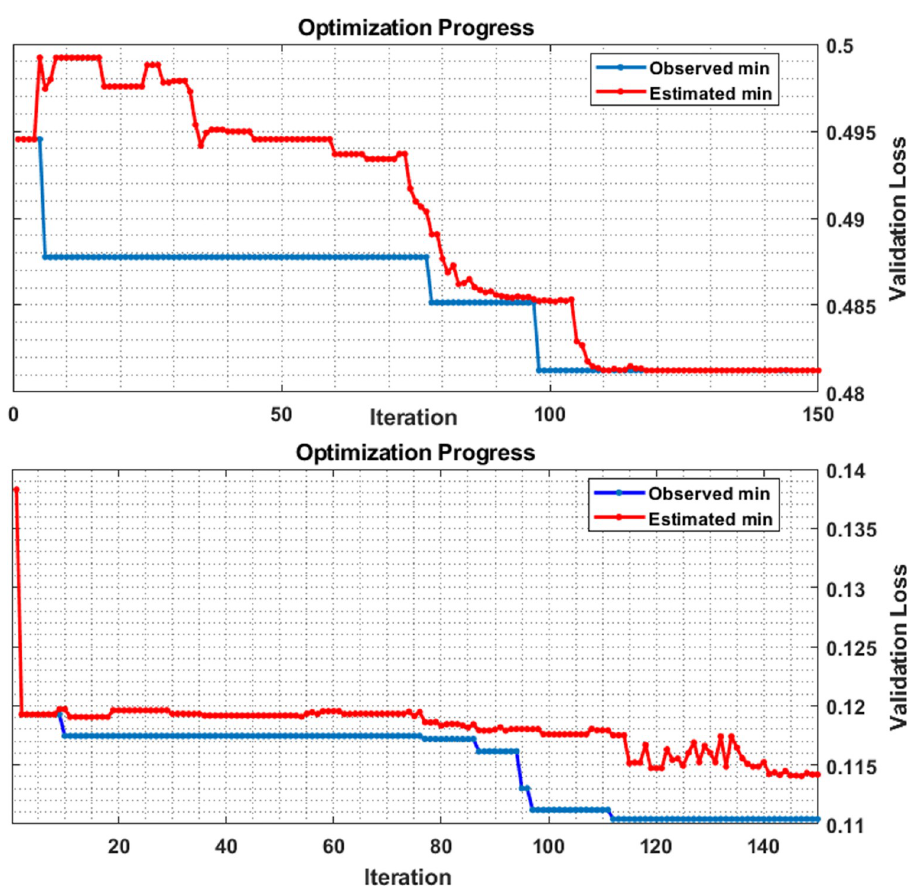
Fig 8. The optimization process for trained models with coherence and sparse analysis as input feeding data. Row 1 shows the training error (based on Validation Loss) for coherence coupling values on 80% of input data and row 2 shows the error of the trained model for the sparse coefficients as input data.